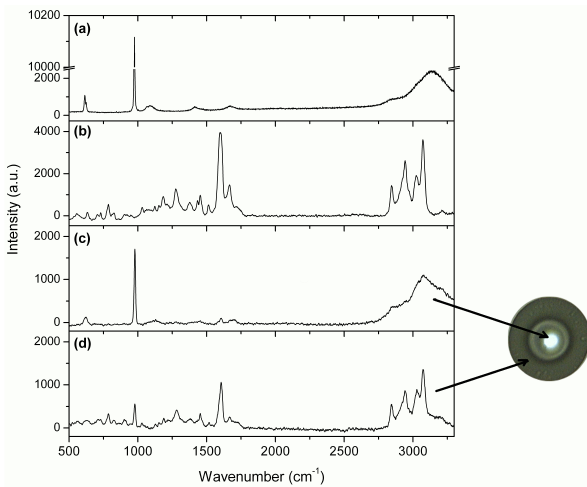
Fig. 3. Raman spectra of (a) a pure ammonium sulfate parti- cle, (b) a pure 4-dihydroxy-3-methoxybenzeneacetic acid particle, (c) the core of a mixed 4-dihydroxy-3-methoxybenzeneacetic acid- ammonium sulfate particle after phase separation, and (d) the shell of a mixed 4-dihydroxy-3-methoxybenzeneacetic acid-ammonium sulfate particle after phase separation. The mixed particle used for Raman analysis (organic-to-sulfate = 1.44) is shown to the right. All Raman spectra were collected at approximately 293 K. In ad- dition, during Raman measurements the particles were exposed to room air, and hence, the RH was not